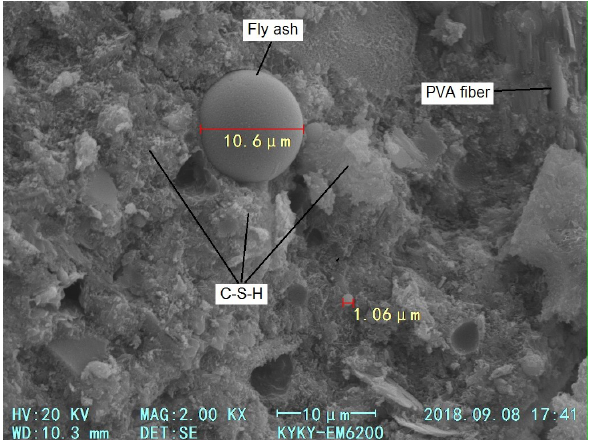
Figure 6: SEM micrographs of PVA fiber reinforced cementitious